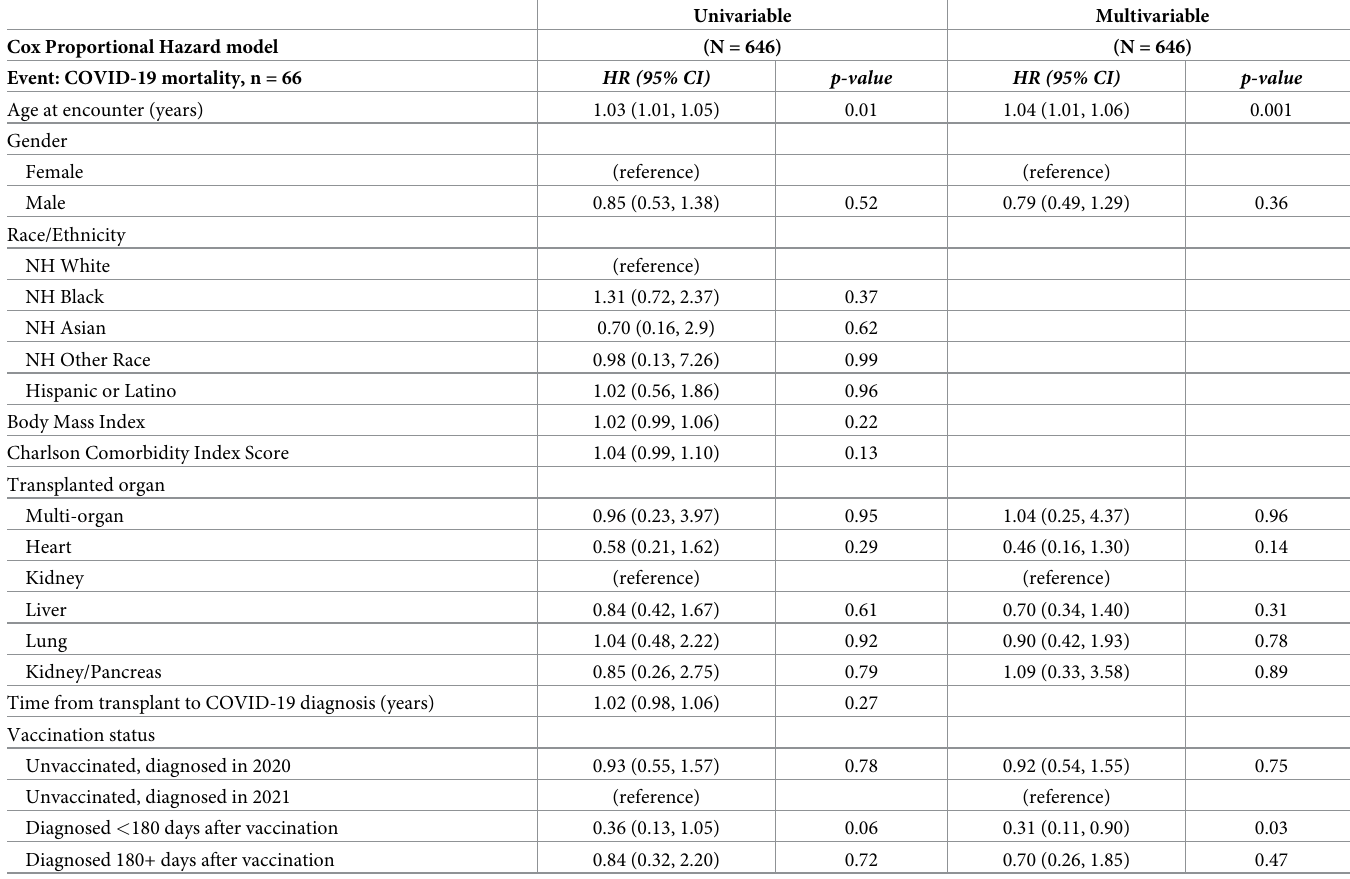
Table 2. 60-day COVID-19 mortality among solid organ transplant